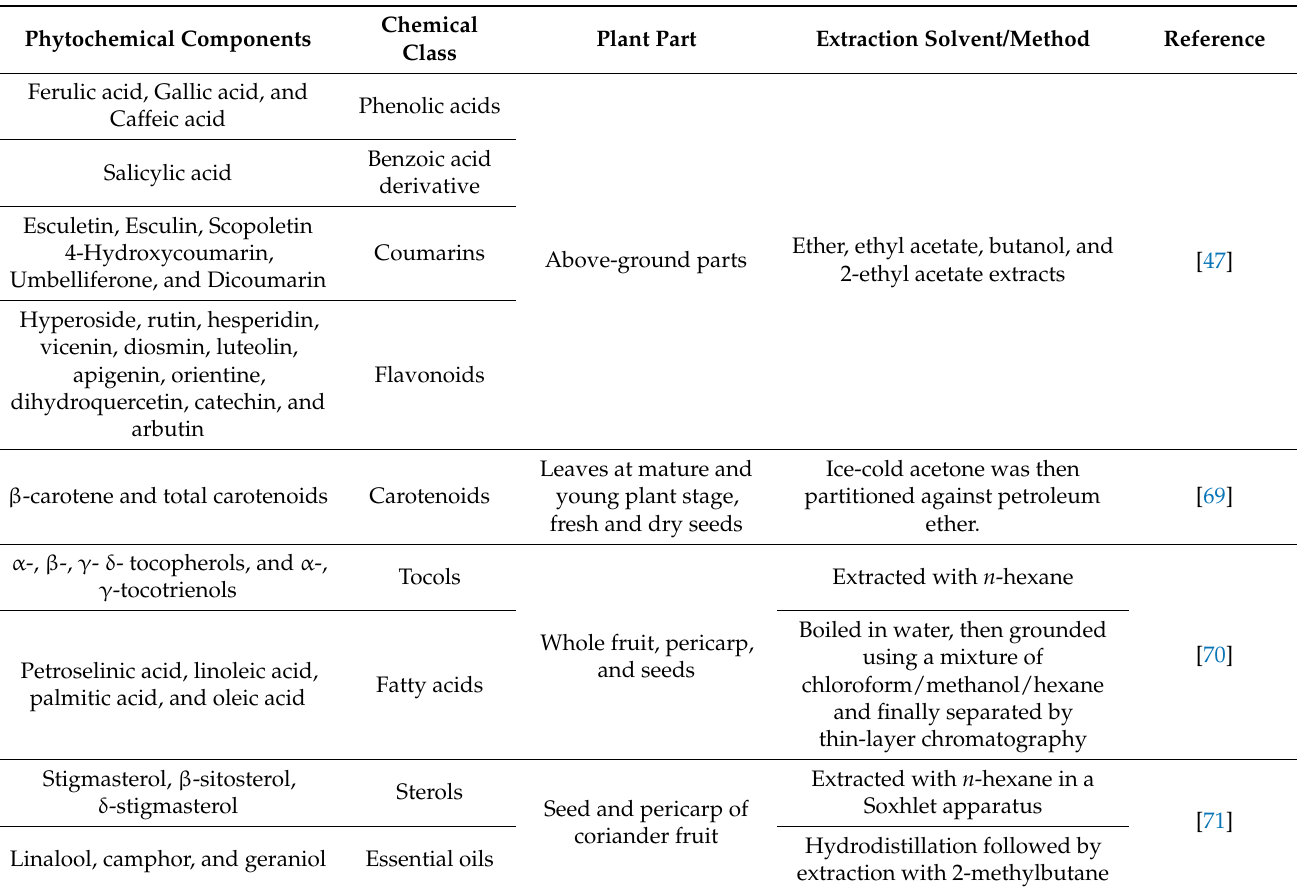
Table 3. Main phytochemical constituents of C. sativum classified according to their chemical class, including the plant part that was extracted and the extraction